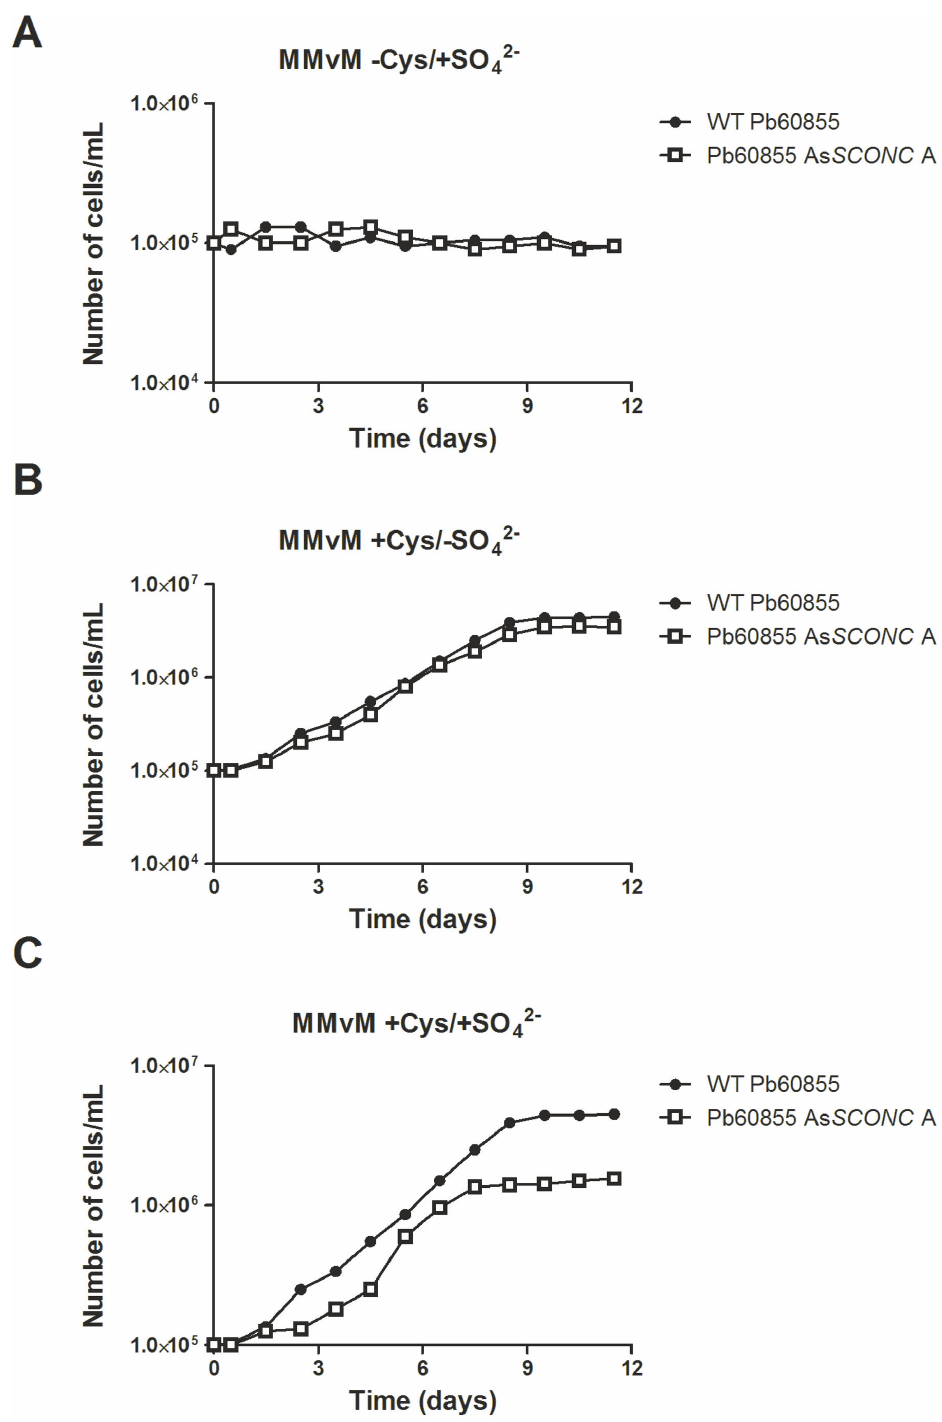
Figure 4. P. brasiliensis AsSCONC transformants do not grow in medium supplemented with inorganic sulfur sources only. P. brasiliensis AsSCONC transformants are unable to grow in medium supplemented with inorganic sulfur sources only (MMvM -Cys/+SO 42- ) and do not sustain yeast growth together with low biomass yield in medium with both organic and inorganic sulfur sources (MMvM +Cys/+SO 42- ). Pb60855 and Pb60855 As SCONC A yeast cells were grown in complete MMvM (MMvM +Cys/+SO 42- ), MMvM without inorganic sulfur supplementation (MMvM +Cys/-SO 42- ) and MMvM without organic sulfur compounds supplementation (MMvM -Cys/+SO 42- ) at 37°C and samples were collected at specific time points to determine growth curves. doi: 10.1371/journal.pone.0074725.g004 PLOS ONE |